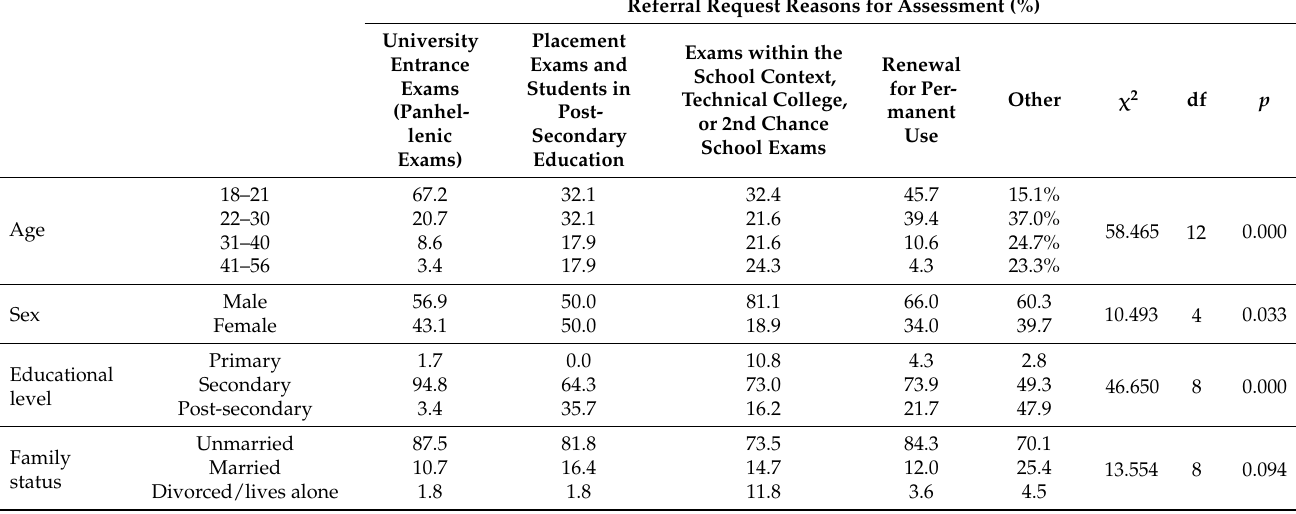
Table A10. Relationship of the Request for assessment with the other